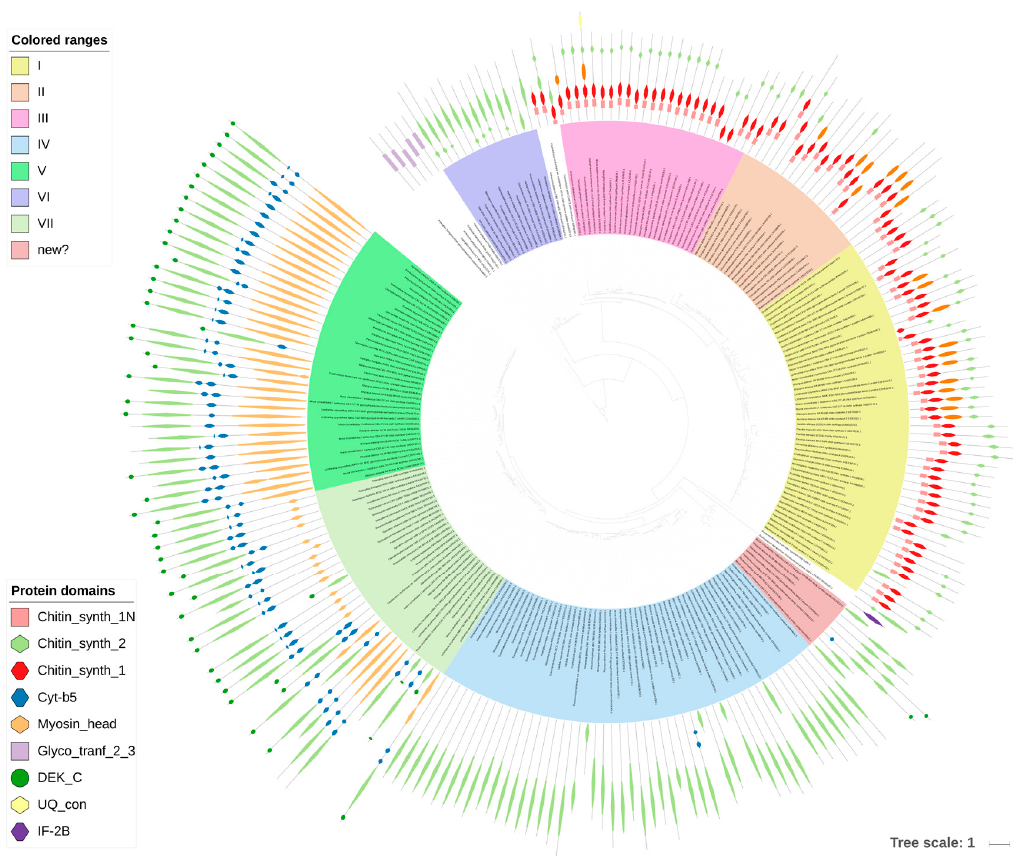
Figure 3. Phylogenetic tree of chitin synthases. The tree was built with PhyML (LG + G model with aLTR branch supports), the image was prepared with iTOL.